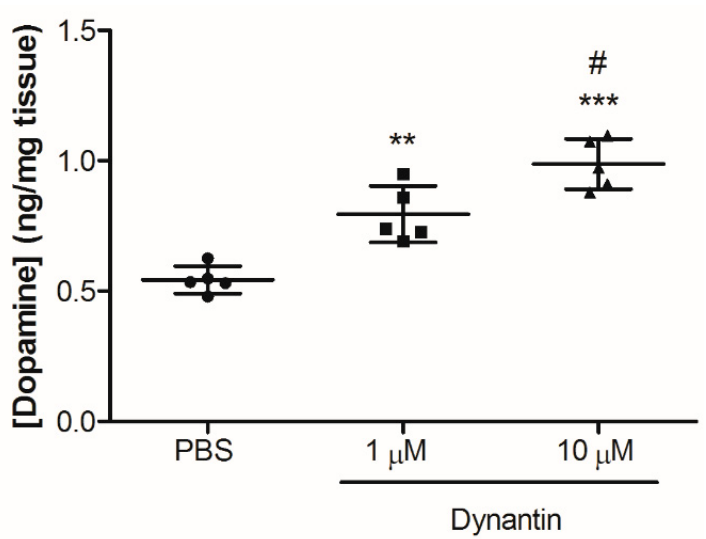
Figure 4. Dynantin in vitro dopamine modulation. Striatal tissue was collected from the brains of sacrificed mice ( n = 15), gently homogenized and then treated with either PBS (60 µ L, n = 5) or dynantin in PBS at a concentration of either 1 µ M (60 µ L, n = 5) or 10 µ M (60 µ L, n = 5) for 90 min at 4 ◦ C in the dark. Dopamine was extracted and its levels analyzed by LC/MS in the presence of 0.1% formic acid. Data are shown as the average ± SD of the 5–6 mice in each group. *** p < 0.001 and ** p < 0.01 as compared to the PBS treatment group, # p < 0.05 as compared to the 1 µ M dynantin treatment group.